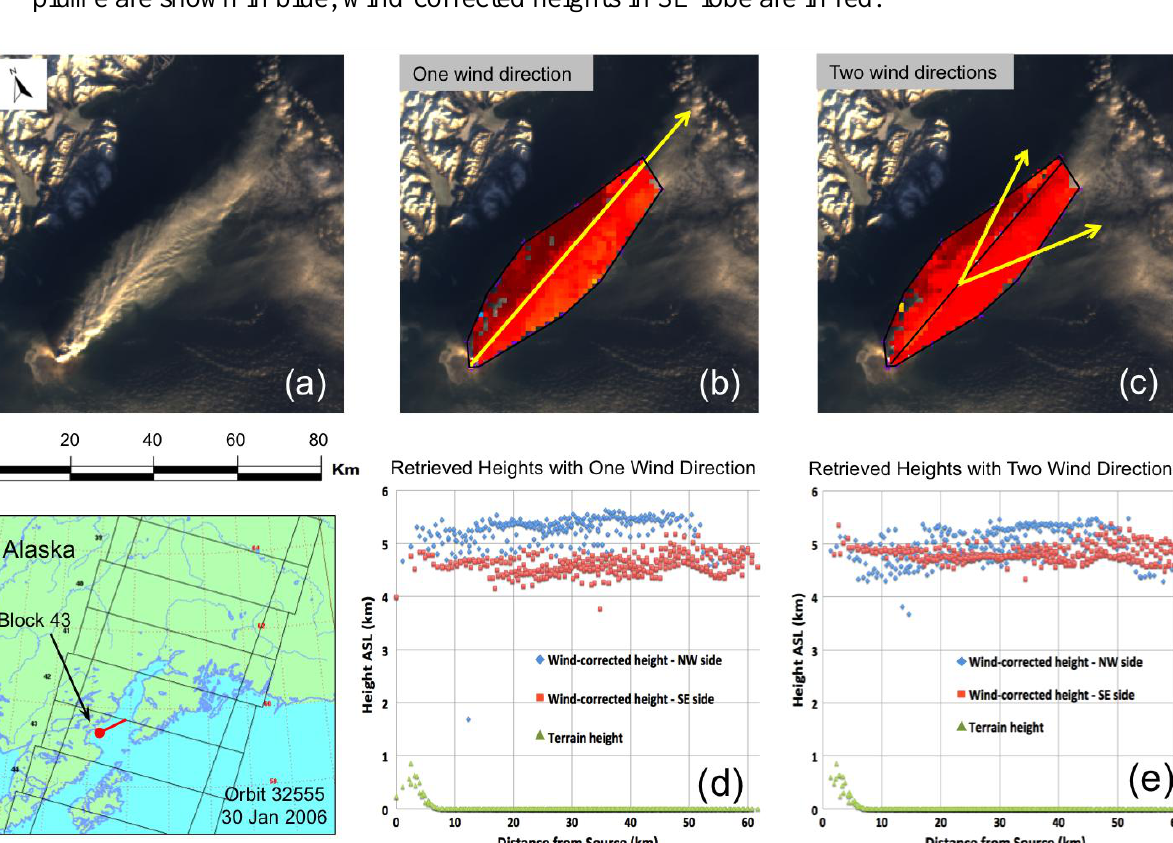
Figure 13. Bifurcated ash plume over Augustine volcano, Alaska, on orbit 32555, block 43: ( a ) Nadir image of plume showing central spine and diverging ribs indicative of vortices caused by wind shear; ( b ) wind-corrected heights in map view retrieved using a single wind direction shown by yellow arrow; ( c ) wind corrected heights in map view retrieved using different wind directions parallel to ribbing in each half of plume; ( d ) profile of wind-corrected heights retrieved using single wind direction; ( e ) profile of wind-corrected heights retrieved using two wind directions. Wind-corrected heights in northwest lobe of plume are shown in blue; wind-corrected heights in SE lobe are in